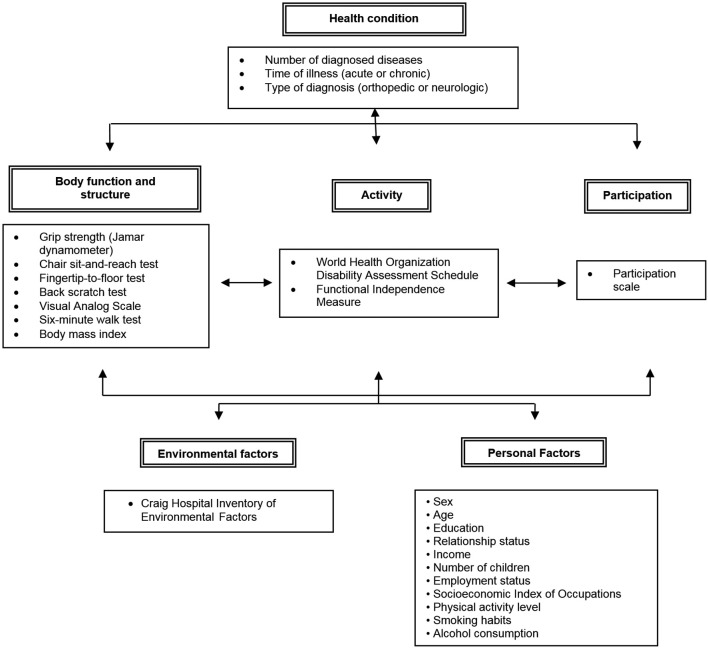
Schema diagram indicating the instrumentation used to measure the different domains of the ICF. Source: Figure adapted from the WHO
2
.